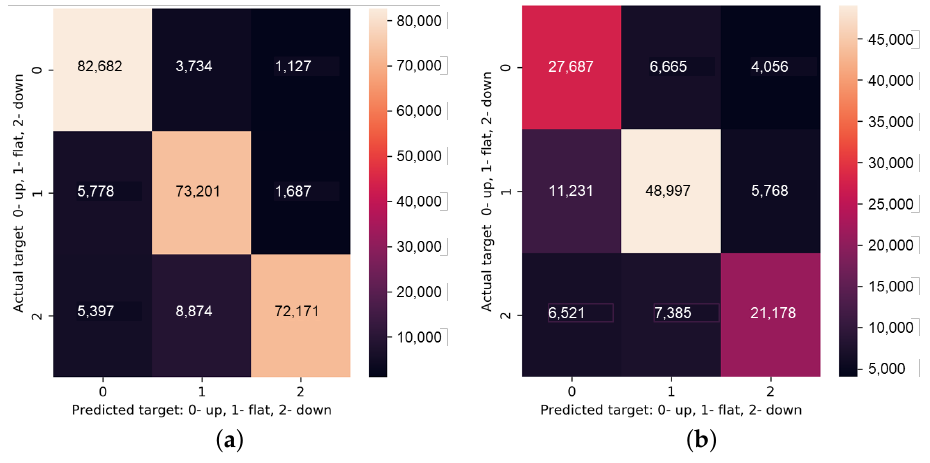
Figure 5. Confusion matrix for the reproducibility experiment. ( a ) Training data sample. ( b ) Valida- tion data